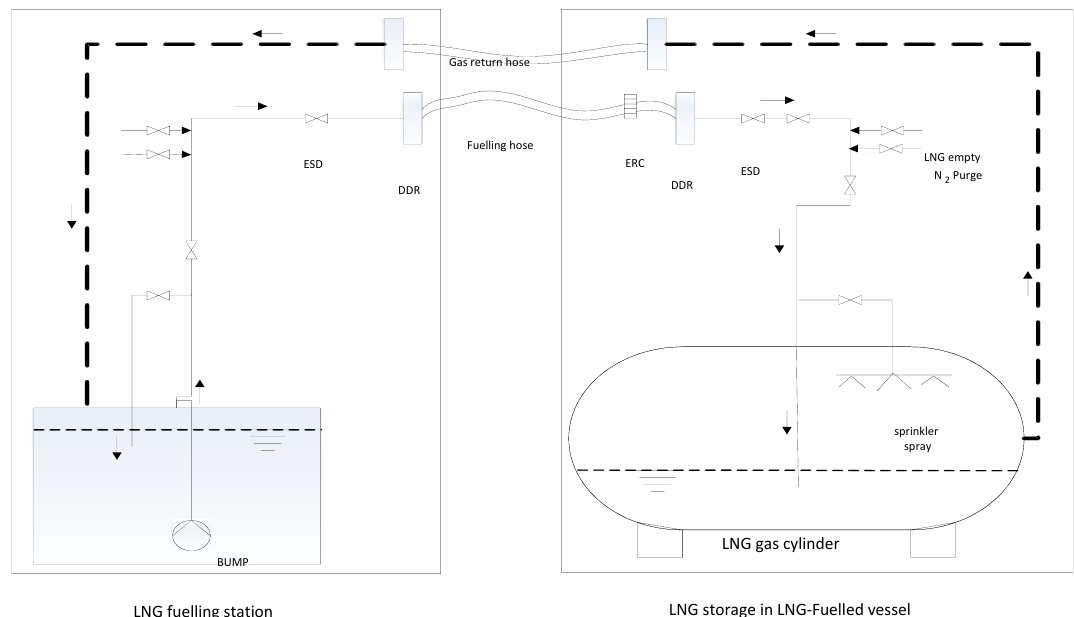
Figure 1. Liquefied nature gas (LNG) intermediary terminal-ship via pipeline (TPS) method.